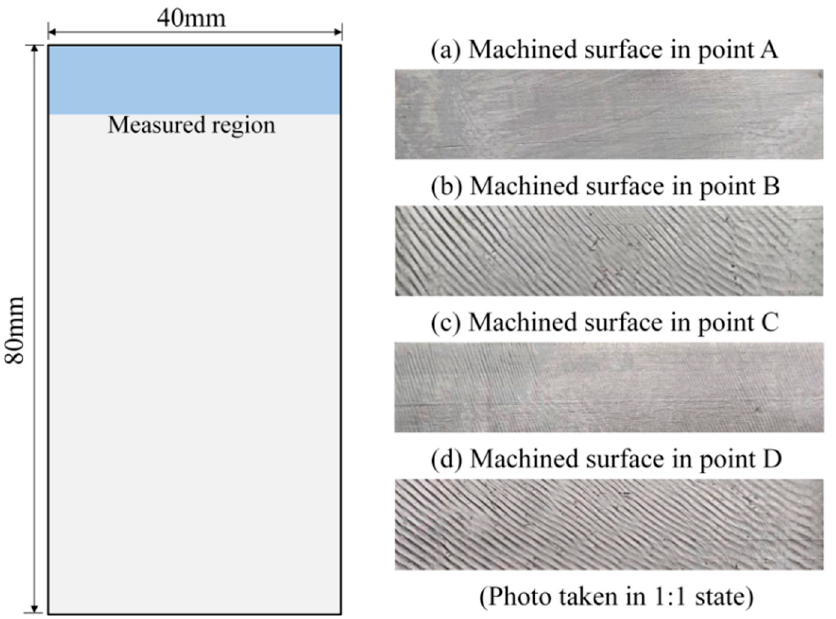
Figure 10. Surface morphology of the thin plate in the milling region.